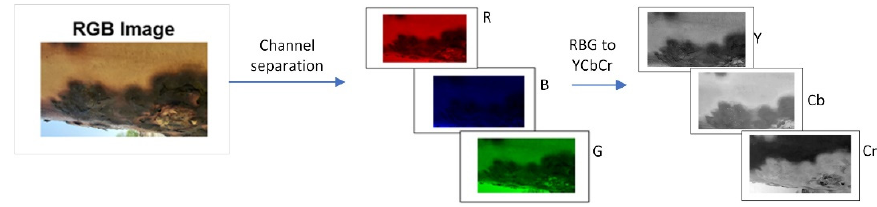
Figure 3. RBG to YCbCr image transformation.